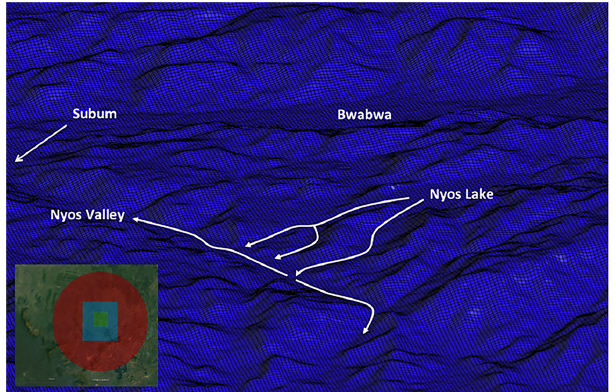
Figure 8. Detail of the ALYA-CFDWind computational mesh (50m horizontal resolution) around the Nyos Lake. The bottom-left in- set shows the extent of the computational domain composed of three differentiated zones, flat buffer (red), transition (pale blue), and inner domain (green) at 50m resolution containing the detailed terrain information. The arrows indicate the approximate gas flow path according to